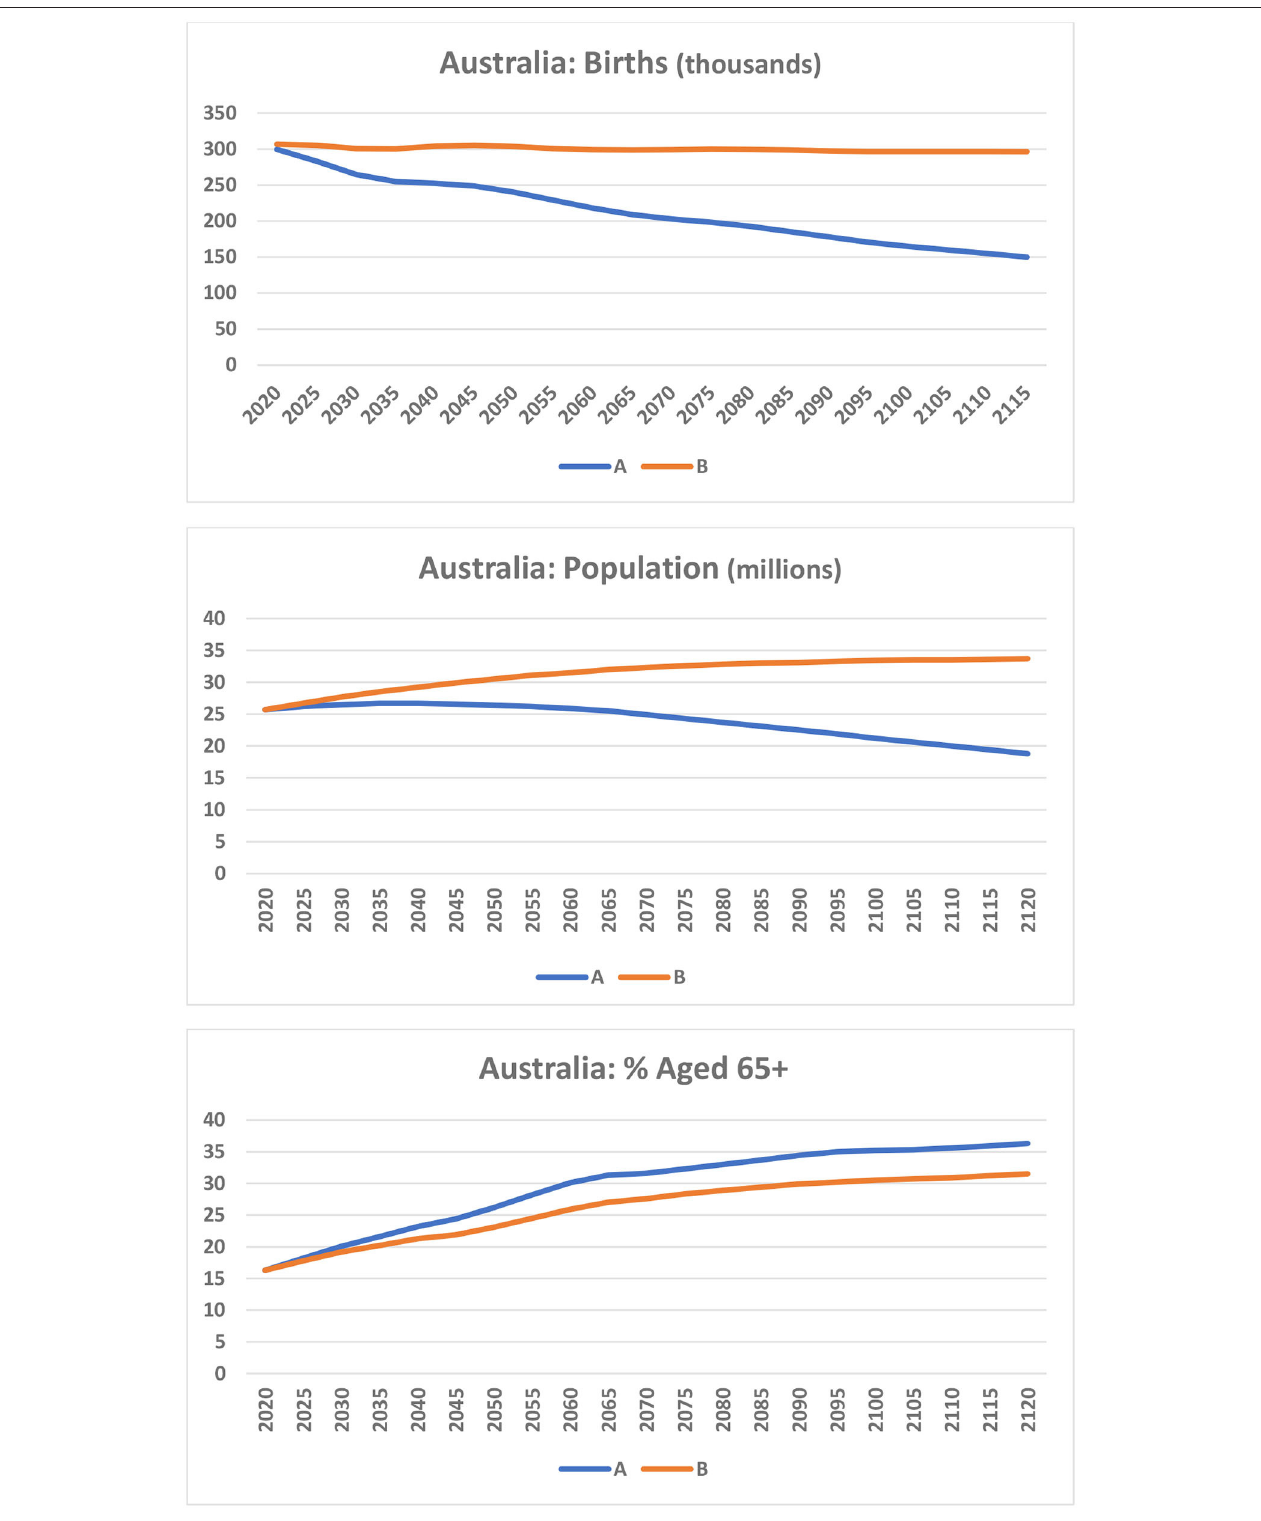
FIGURE 2 | Australia: Projections of births, population and percent of population aged 65 + . A: TFR = 1.65; Net migration = 0. B: TFR = 1.65; Net migration = 100,000.